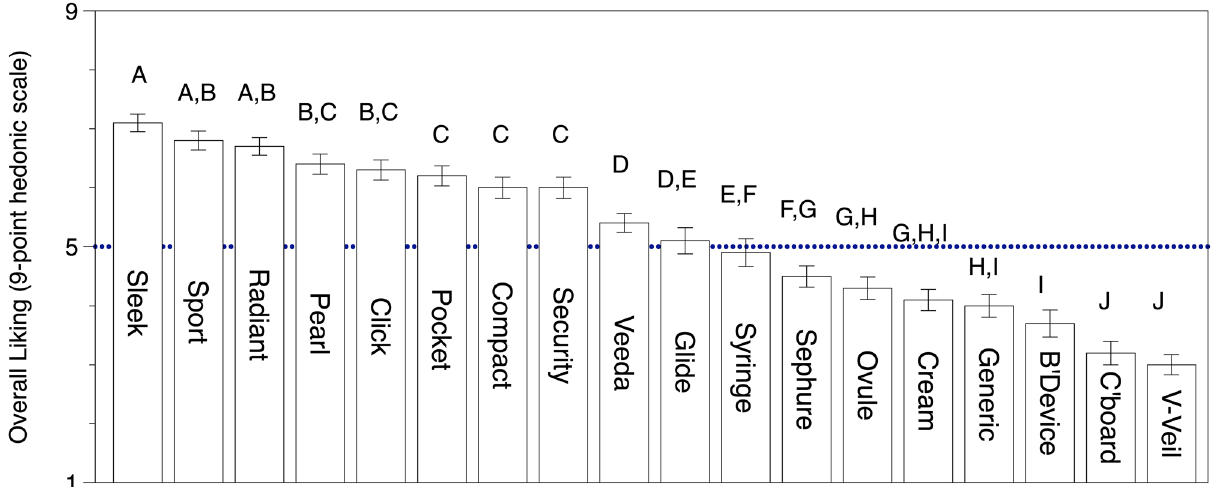
Figure 2. Overall liking means and standard errors (bars) for all 18 applicators measured using a classical 9-point hedonic scale, where 1 = Dislike extremely and 9 = Like extremely, and 5 is a neutral point (‘neither like nor dislike’), ordered with higher liked applicators to the left of the plot. Mean ratings with an upper case letter in common are not significantly different in liking at α = 0.05 (Fisher’s LSD). Most of the products to the left are plastic tampon applicators while those to the right are plastic medication applicators; a cardboard tampon applicator also falls on the right.